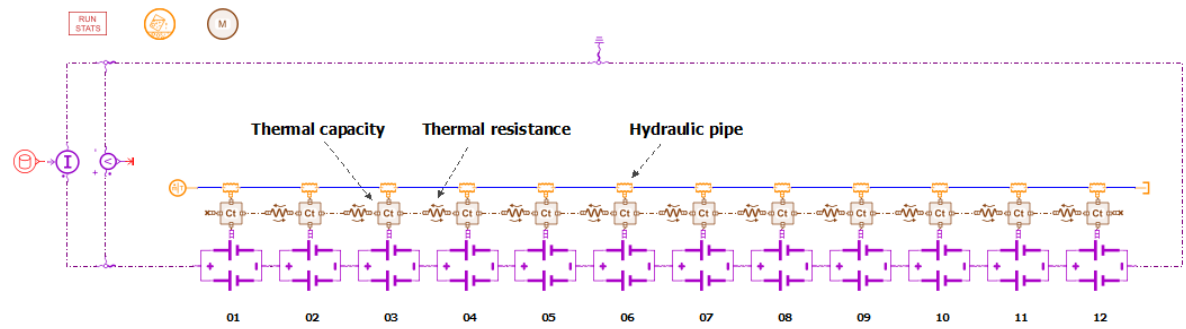
Figure 10. System simulation model in Simcenter Amesim of a liquid cooled 12S2P stack.